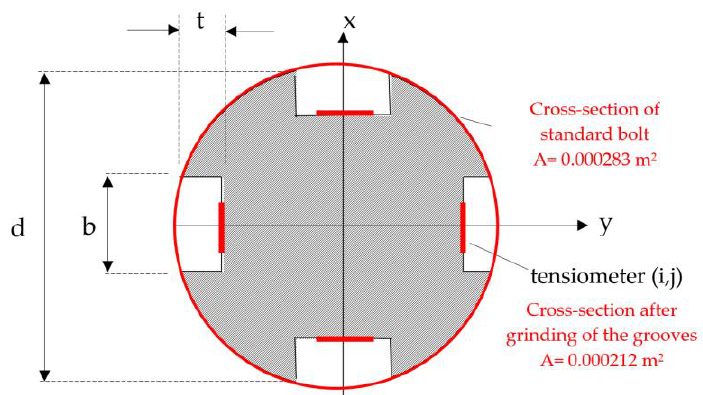
Figure 3. Geometry of the rock bolt and its accessories (t = 3 mm, b = 6 mm, d = 19 mm).